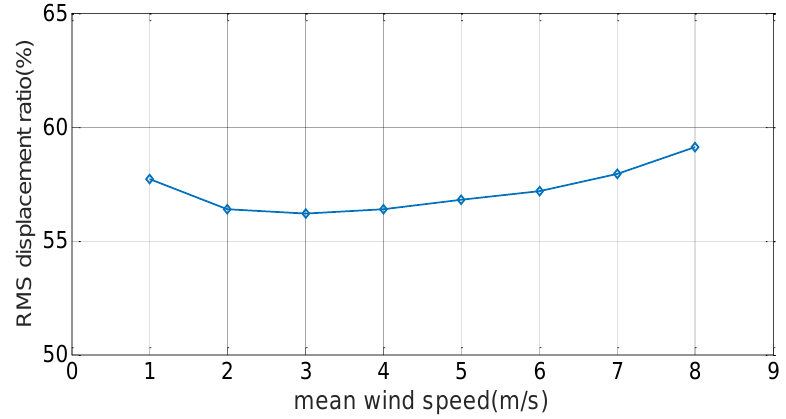
Figure 14. RMS response ratio for mean wind speed variation.